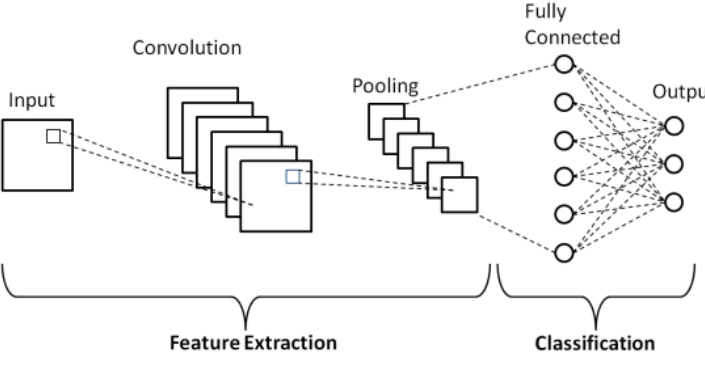
Figure 2. CNN Figure 2. CNN Architecture.